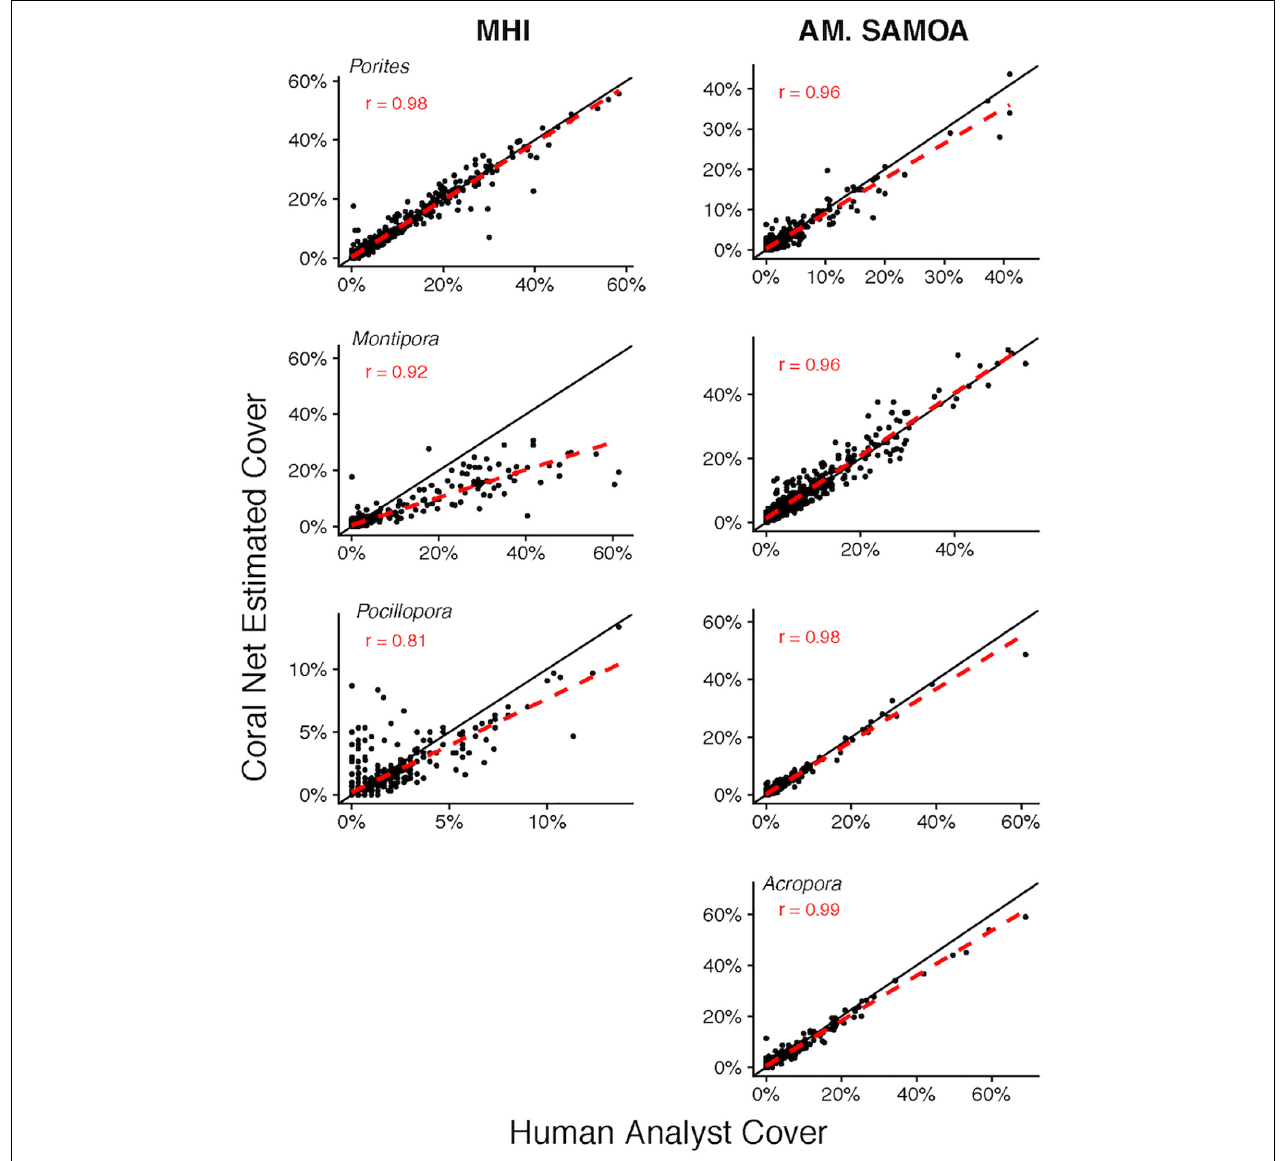
FIGURE 4 | Site-level coral cover of common genera by human analyst and CoralNet. Figures in the left column are for MHI sites, and in the right column for American Samoa. Each point represents a single site; the solid black line is the 1:1 line, and the dashed red line is a linear fit of the point data. Acropora were not recorded at MHI sites. CoralNet was trained using the “SIMPLER” classifications ( Supplementary Table S2 ). “r” values are Pearson’s correlation coefficients. Total number of sites is 598 for MHI, and 468 for American Samoa. Correlations are significant ( p < 0.0001) in all